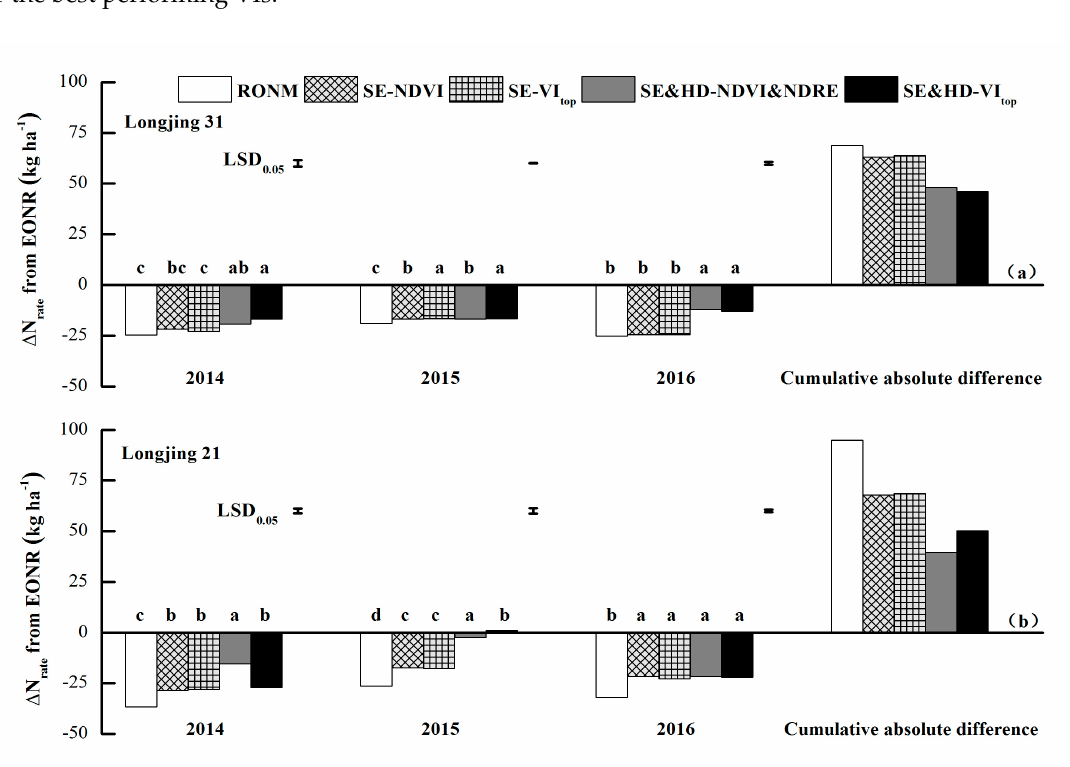
Figure 6. The di ff erence of recommended topdressing N application rate ( ∆ N rate ) from economically optimal N rates (EONR) between RONM strategy and RapidSCAN sensor-based PNM strategies for the rice varieties of Longjing 31 ( a ) and Longjing 21 ( b ) under deficient N status before topdressing (N80) in 2014–2016. RONM: the regional optimum N management topdressing N rate (36 kg N ha − 1 in this study). SE-NDVI and SE-VI top indicated recommended topdressing N application rate calculated by the models based on NDVI and the top performing VIs (VI top ) for di ff erent varieties at stem elongation stage, respectively. SE&HD-NDVI&NDRE and SE&HD-VI top indicated recommended topdressing N application rates calculated by the models with NDVI (at stem elongation stage) and NDRE (at heading stage), and VI top at stem elongation and heading stage, respectively. Vertical bars represent the LSD value ( p = 0.05). Di ff erent letters indicate significant di ff erence at p < 0.05 level within the same